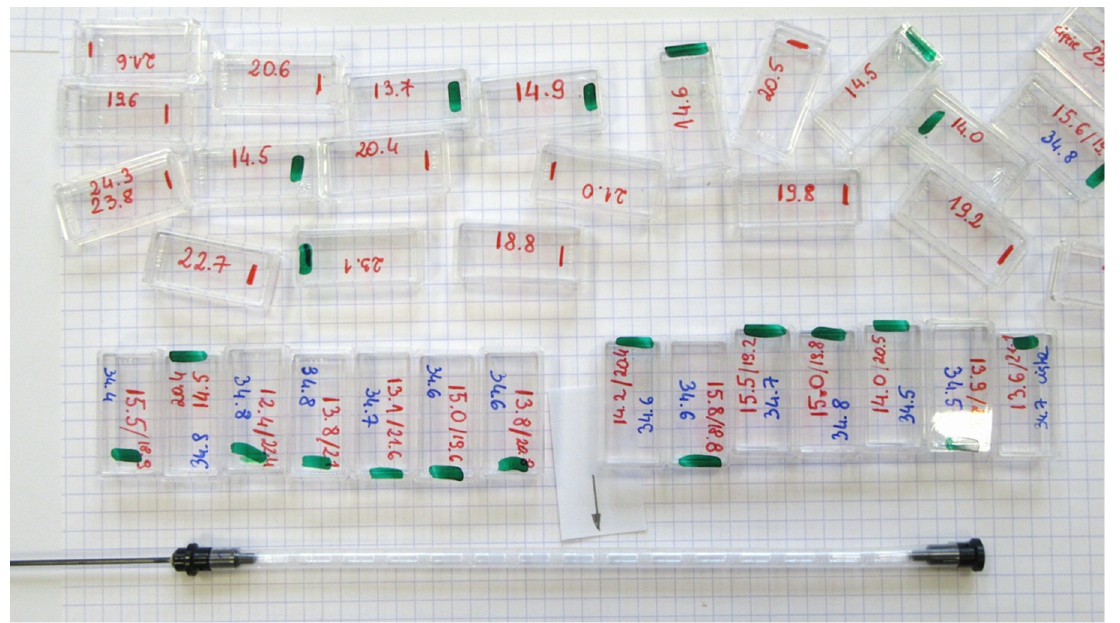
Figure 7. ( Bottom ) Fully assembled capsule compensated sample holder (C-CSH) made from 15 #5 polycarbonate capsules tightly combined in an S2 straw to make the self-compensated train. The arrow marks the position in which a small object will reside during the measurements. ( Top ) The markings on the plastic boxes located just above the C-CSH state the weight of each capsule used to assembly the train. Other boxes at the upper half of the figure are the leftovers from the capsule selection process.